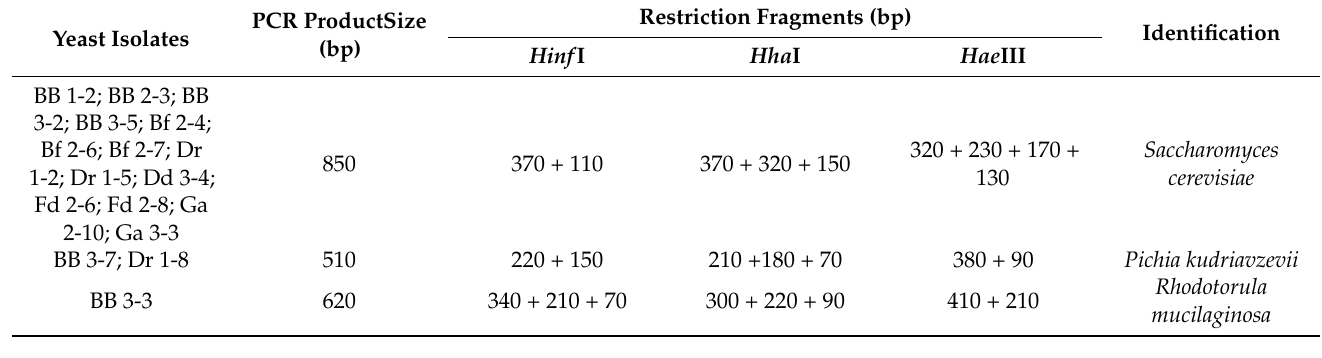
Table 1. Molecular identification of yeast isolates by RFLP analysis of the 5.8S-ITS regions.